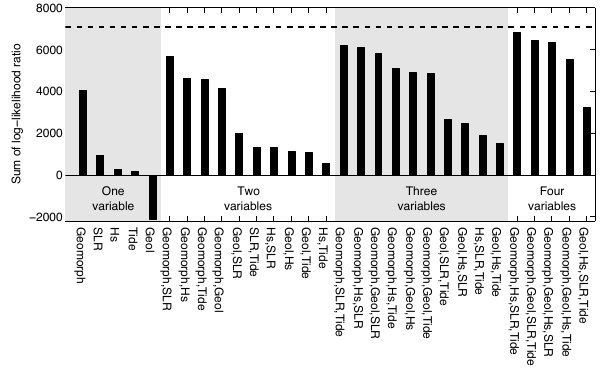
Fig. 2. The sum of the log-likelihood ratio (LR) for tests using be- tween one and four variables. The horizontal dashed line indicates the sum of the LR when all five variables are